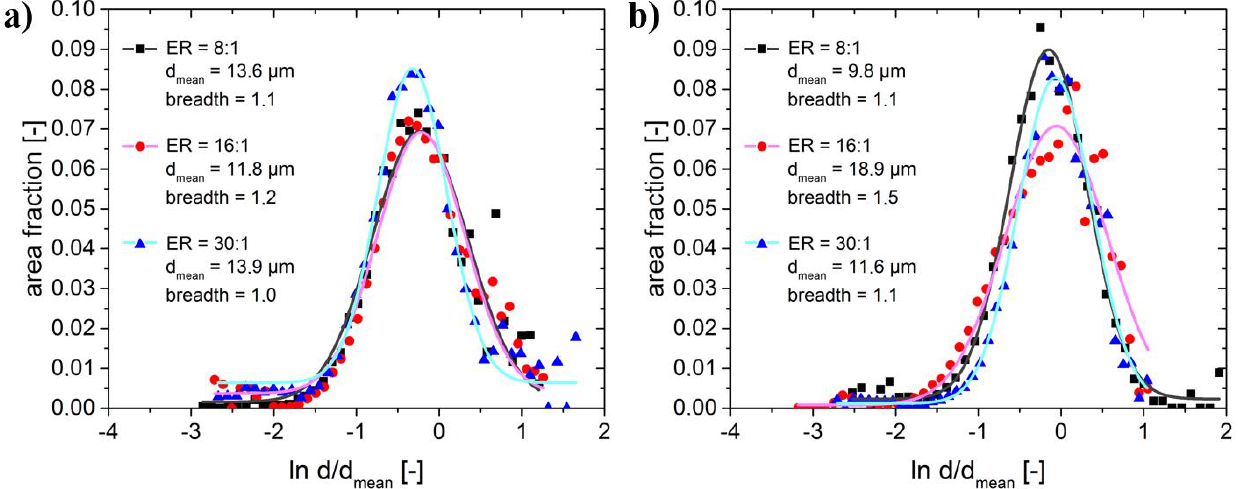
Figure 3. Normalized grain size distribution of recrystallized grains: ( a ) in the reference area and ( b ) in the weld seam .